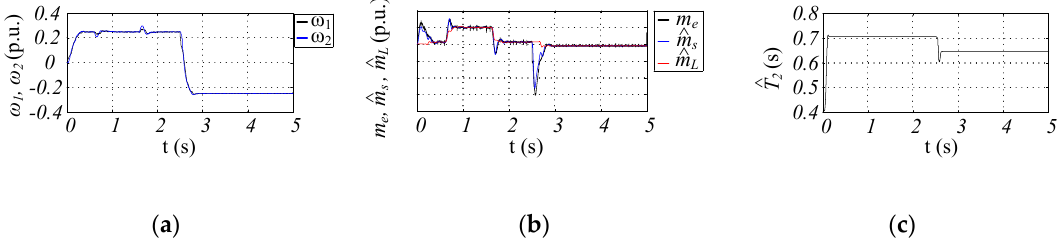
Figure9. TransientsprocessoftheadaptivecontrolstructurewiththeFUKFestimator—theexperimental Figure 9. Transients process of the adaptive control structure with the FUKF estimator – the results: the motor and load angular speeds ( a ), the electromagnetic, shaft and load torques ( b ), experimental results: the motor and load angular speeds (a), the electromagnetic, shaft and load the estimated value of the load time-constant of the machine ( c ) for a small value of the rated torques (b), the estimated value of the load time-constant of the machine (c) for a small value of the speed rated speed signal.